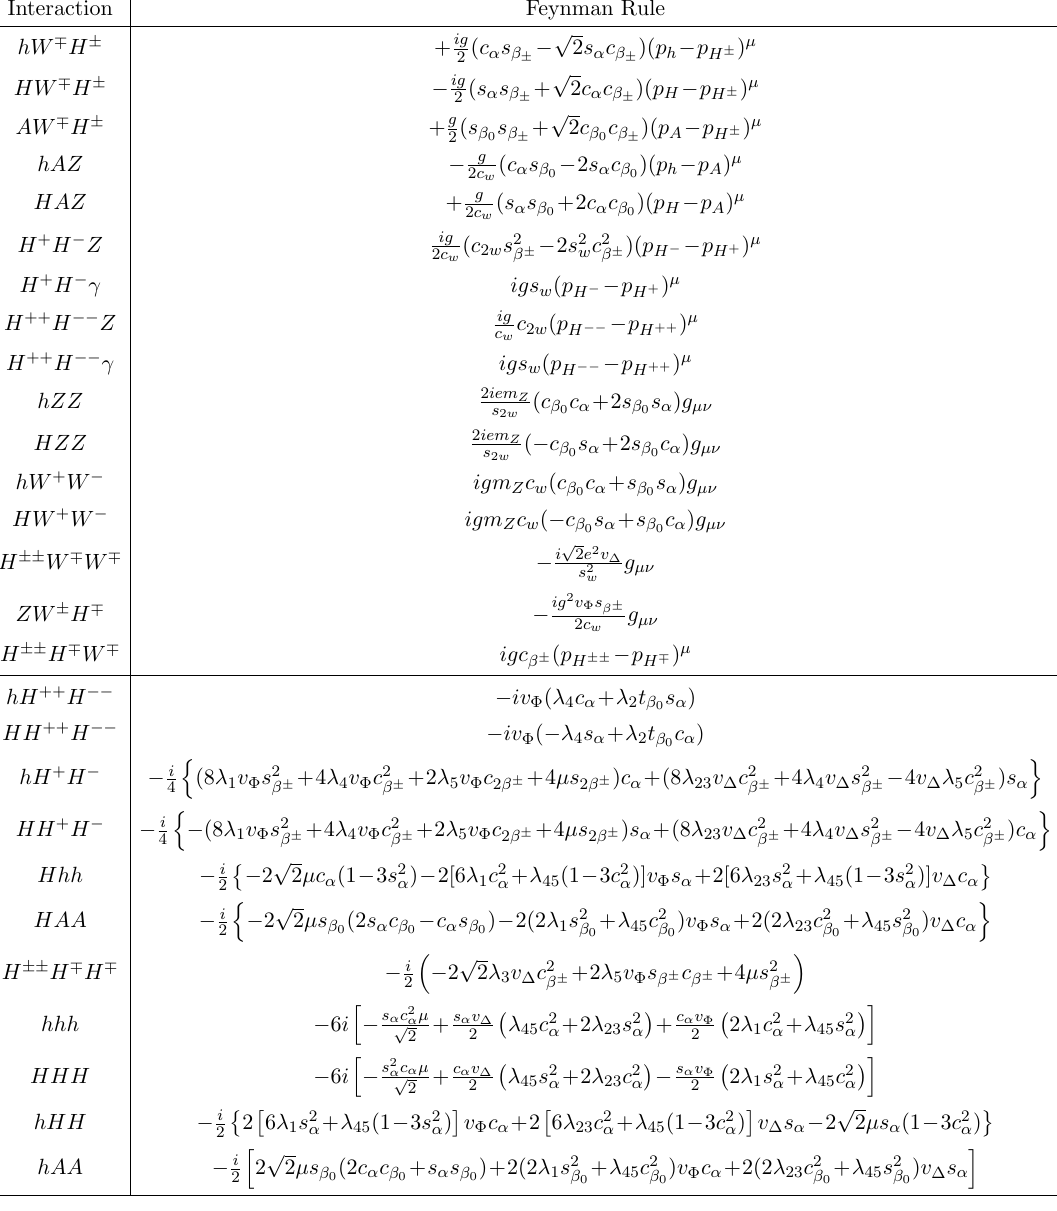
Table 11 . Feynman rules for the